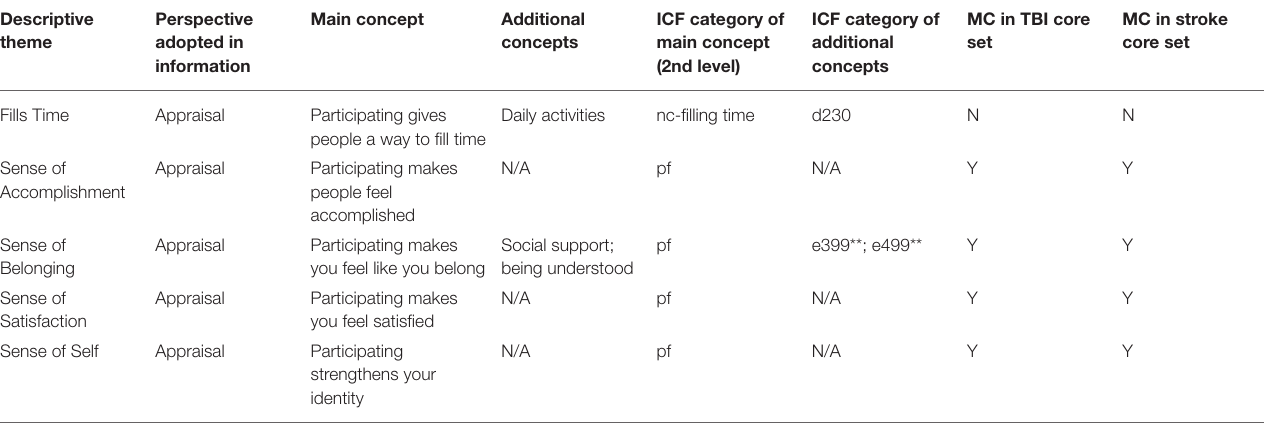
TABLE 8 | ICF linking to themes from outcomes of